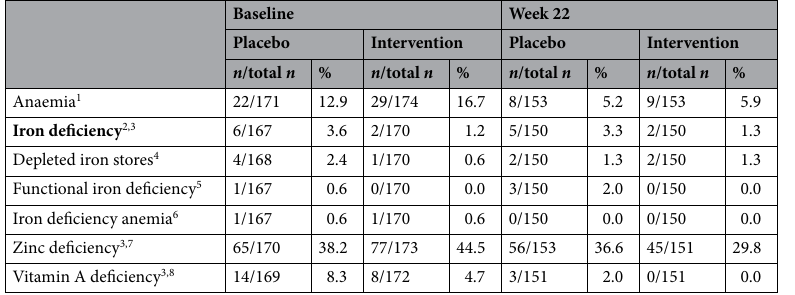
Table 5. Raw estimates for the prevalence of anaemia and deficiencies of iron, zinc, and vitamin A. 1 Defined as haemoglobin < 115 g/L 35 . 2 Defined as depleted iron stores, functional iron deficiency, or iron deficiency anaemia 35 . 3 Serum ferritin, plasma zinc, and plasma retinol concentrations were corrected for inflammation for all children with a C-reactive protein concentration > 5 mg/L at a given time point 40,41 . 4 Defined as a serum ferritin concentration < 15 µg/L 36 in the absence of functional iron deficiency or anaemia. 5 Defined as ≥ 2 abnormal values for serum ferritin (< 15 µg/L), mean corpuscular volume (< 80 fL), and red blood cell distribution width (> 14.5%) in the absence of anaemia 37 . 6 Defined as haemoglobin < 115 g/L in the presence of functional iron deficiency 37 . 7 Defined as plasma zinc < 9.9 µmol/L 34 . Plasma zinc was adjusted for time of day of blood sampling before correcting for inflammation 42 . 8 Defined as a plasma retinol < 0.70 µmol/L 38,39